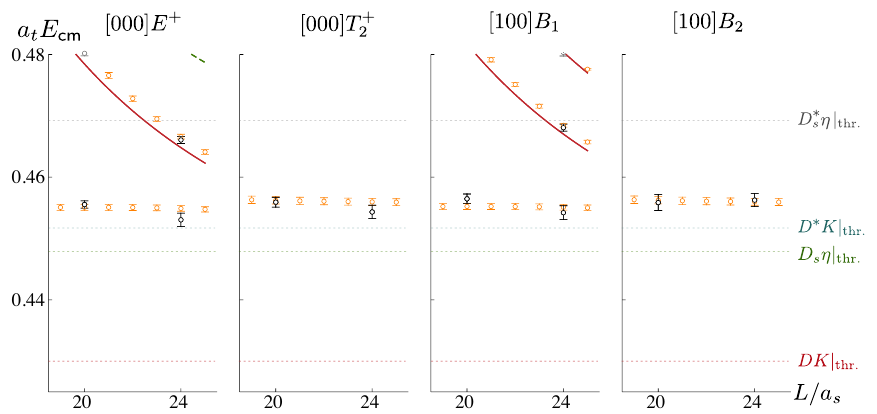
Figure 12 . DK I = 0 finite-volume spectra on the m π = 391 MeV ensembles, as in the bottom row of figure 4 where black points indicate the computed finite-volume energy levels, with the addition of orange points which show the energy levels from the parametrisation in eq. (5.11).